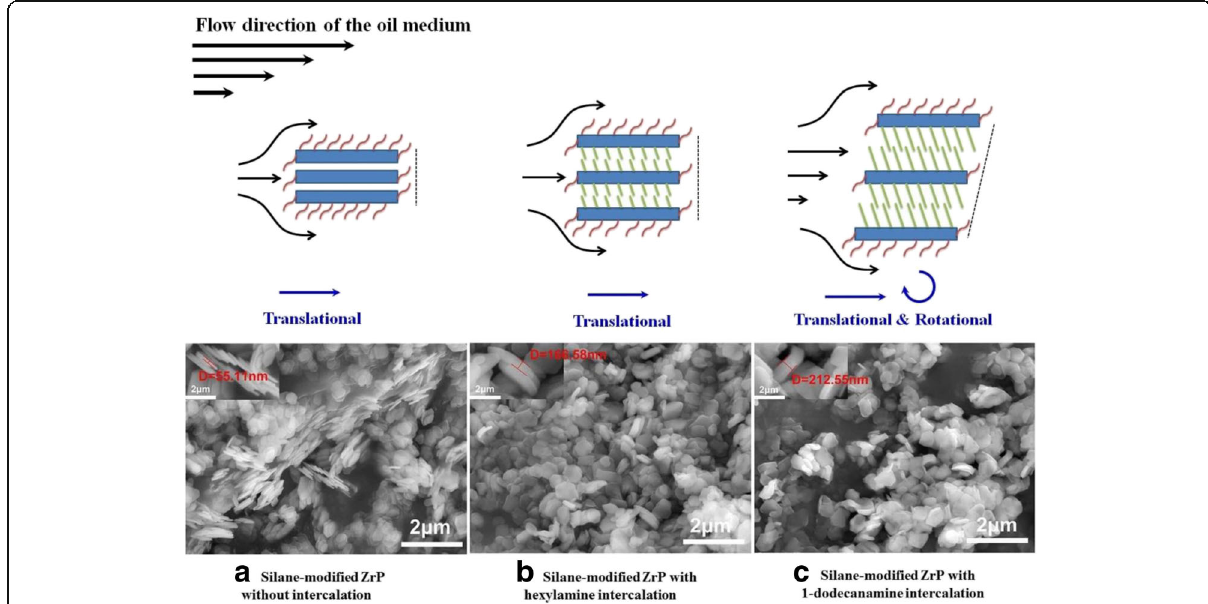
Fig. 7 Proposed rheological behaviors of surface-modified ZrP nanoplatelets with and without intercalations in oils. The layered nanoplatelets shown in the cartoon are not drawn to scale. The bottom is the corresponding SEM images of surface-modified ZrP nanoplatelets with and without intercalations. a Silane-modified ZrP nanoplatelets without intercalation (thickness is ~55 nm). b Silane-modified ZrP nanoplatelets with hexylamine intercalation (thickness is ~160 nm). c Silane-modified ZrP nanoplatelets with 1-dedecanamine intercalation (thickness is ~210 nm)